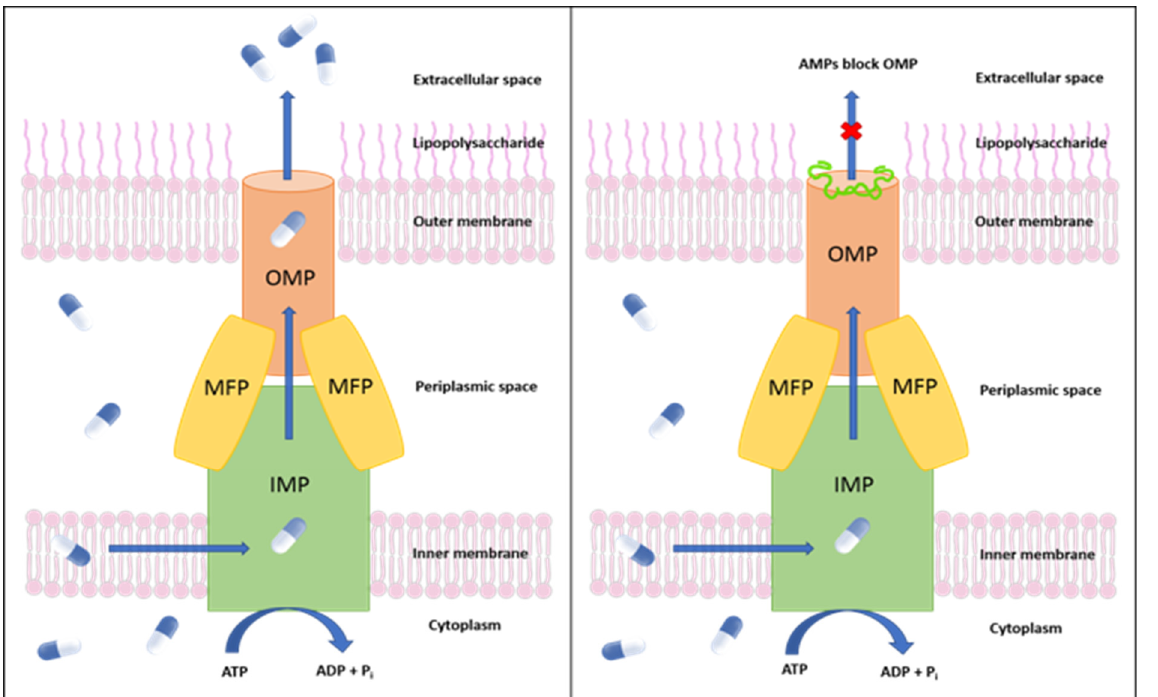
Figure 1. Left: Schematic representation of an efflux pump in Candidatus Liberibacter asiaticus. Right: Inhibition of the C Las TolC outer membrane protein by (AMPs). MFP: membrane fusion protein; IMP: inner membrane protein.